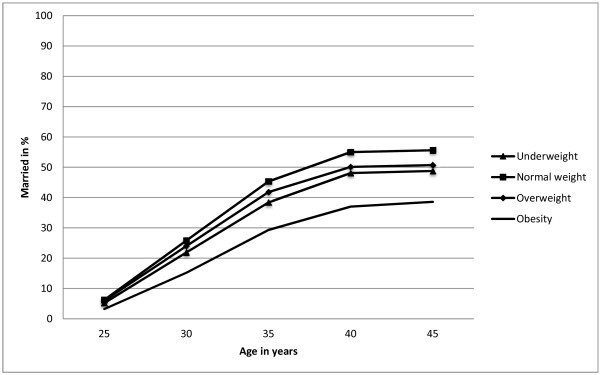
Percentages of 25- to 45-year-old married men, born between 1951 and 1961 in Sweden, according to weight status at 18 years of age. Marital status is taken between 1976 and 2006.